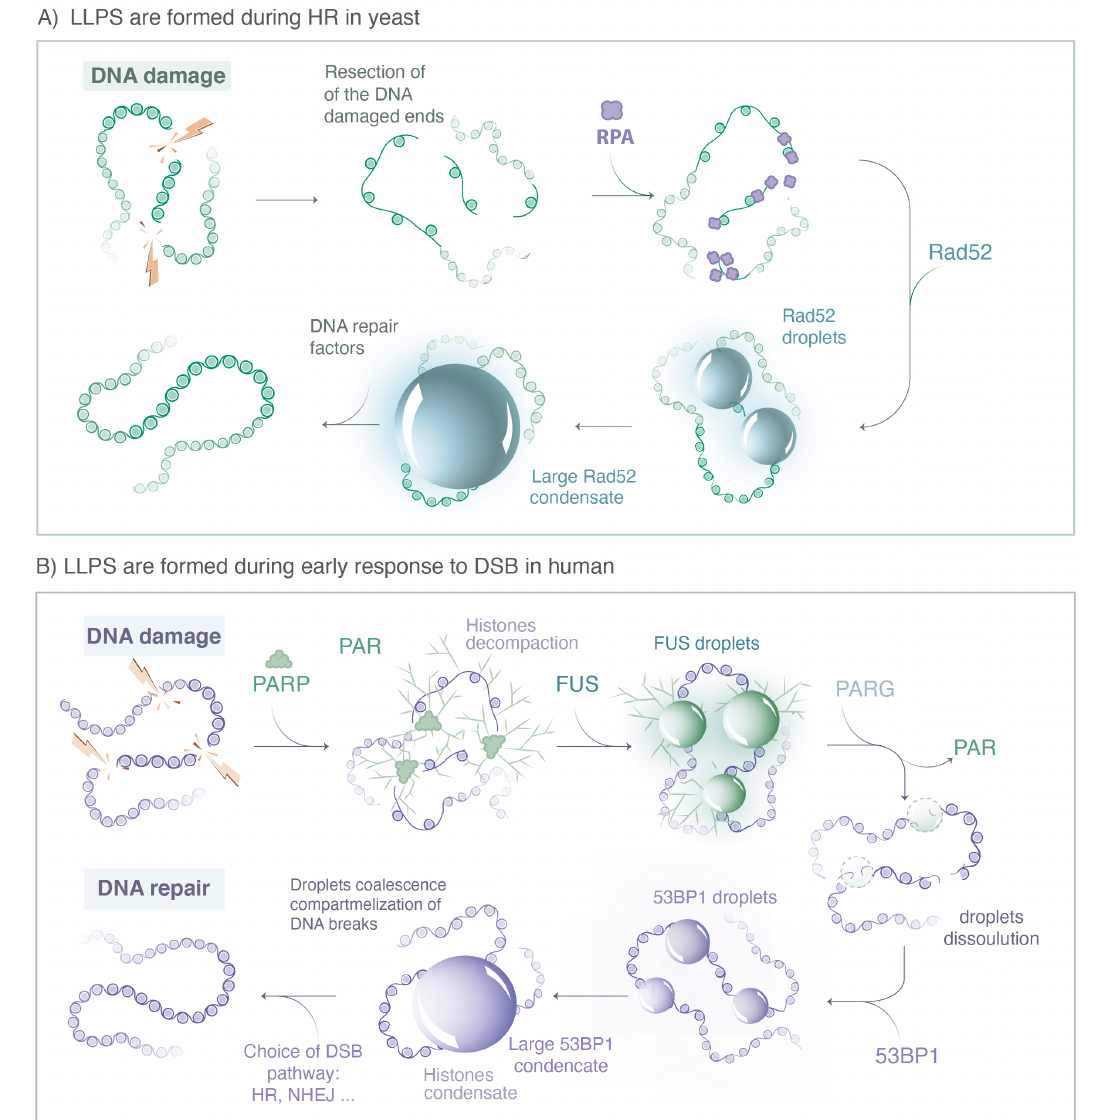
Figure 3. Repair proteins known to form LLPS during DSB repair. ( A ) In yeast, when a DSB is Figure 3. Proposed algorithm flow diagram repaired by HR, the 5 (cid:48) ends of the DNA break are resected by nucleases to yield 3 (cid:48) single-stranded DNA (ssDNA) tails that are rapidly coated by the RPA complex. The Rad52 protein, the functional analog of human BRCA2 in yeast, then stimulates the removal of RPA. The ssDNA-binding protein Rfa1, a subunit of the RPA complex, and Rad52 form both visible foci at damaged sites; however, they exhibit very different behavior at the microscopic level. While most Rfa1 molecules are bound to the ssDNA, Rad52 molecules exhibit several hallmarks of LLPS. Changing the concentration of Rad52 behaviors is consistent with a client of an LLPS. ( B ) In human cells, immediately after DNA damage, the PARP proteins family is recruited at the sides of single and double strand breaks, inducing damaged sites, likely through a binding mechanisms without forming LLPS. The FET family proteins (FUS, EWS, TAF15) binds PAR chains formed at damaged sites. PAR chains initiate the formation of FUS, EWS and TAF15 condensates, which show several hallmarks of LLPS. After dePARylation by PARG, these droplets are dissolved and replaced by 53BP1 condensates, also exhibiting hallmarks of LLPS. (Illustration by Min é -Hattab and Olga